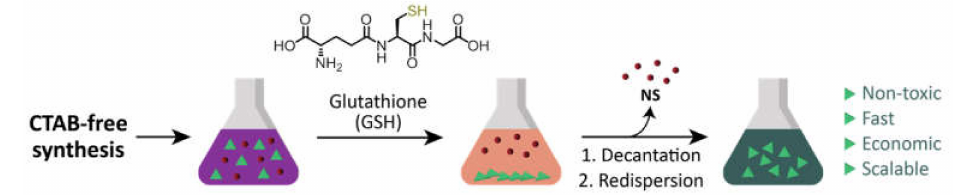
Figure 1. Proposed purification of gold nanoprisms (NPrs) from a mixture with gold nanospheres